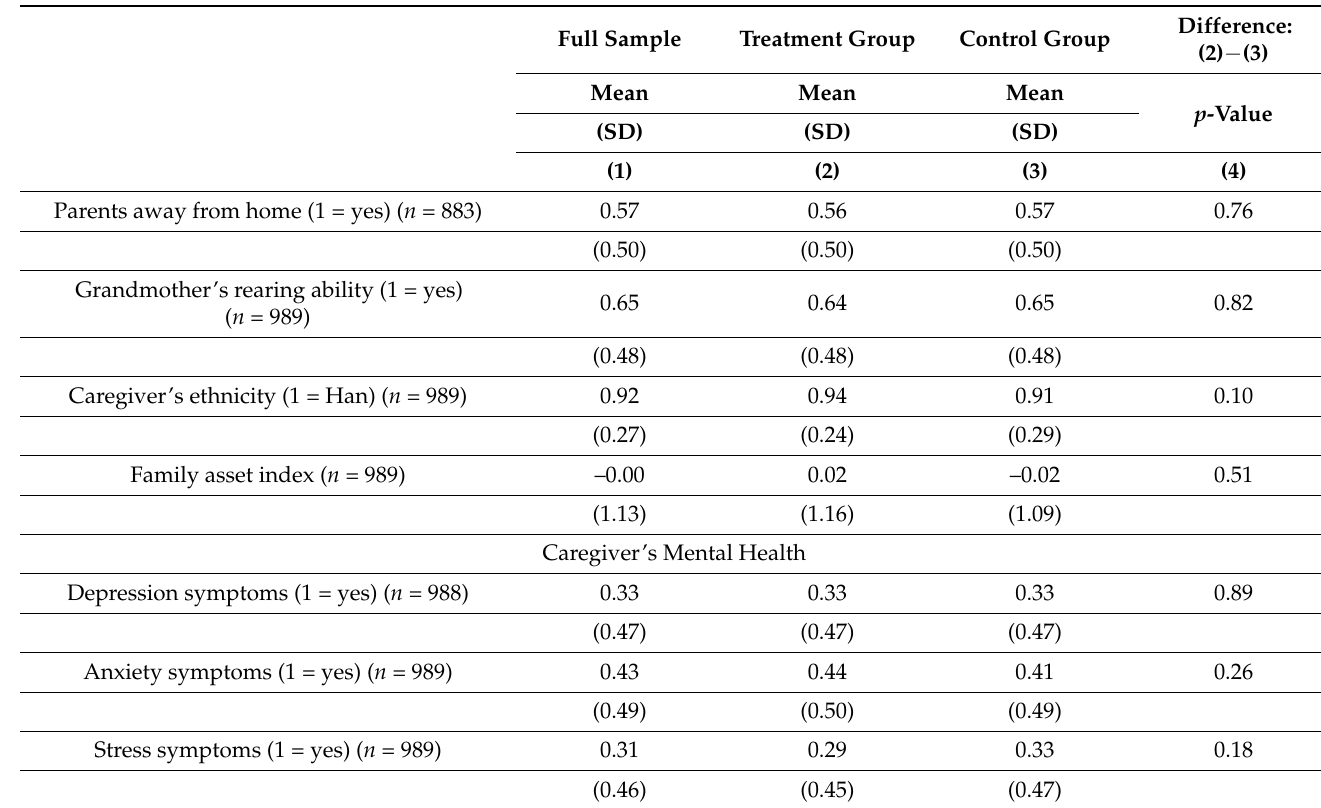
Table 1. Cont. Full Sample Treatment Group Control